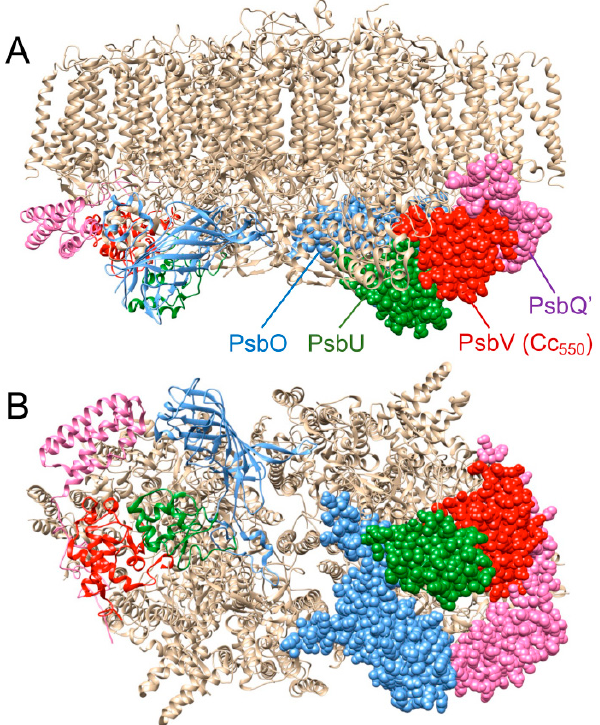
Figure 3. Photosystem II core of the diatom C. gracilis , PDB code, 6jlu [17]. ( A ) Membrane lateral view; ( B ) bottom luminal view (90° rotation). The main extrinsic subunits are highlighted: PsbO (blue), PsbV/cytochrome c 550 (red), PsbU (green), PsbQ’ (purple). The Figure was generated with the UCSF Chimera program (version 1.16; http://www.rbvi.ucsf.edu/chimera/).